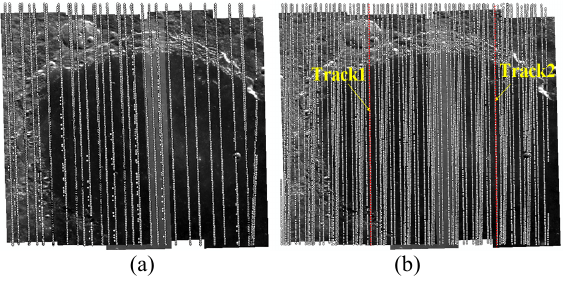
Figure 3. The registered Chang’E-1 (a) and SELENE laser altimetry data (b) directly overlaid on the Chang’E-1 images (backward images) at the Sinus Iridium area, respectively